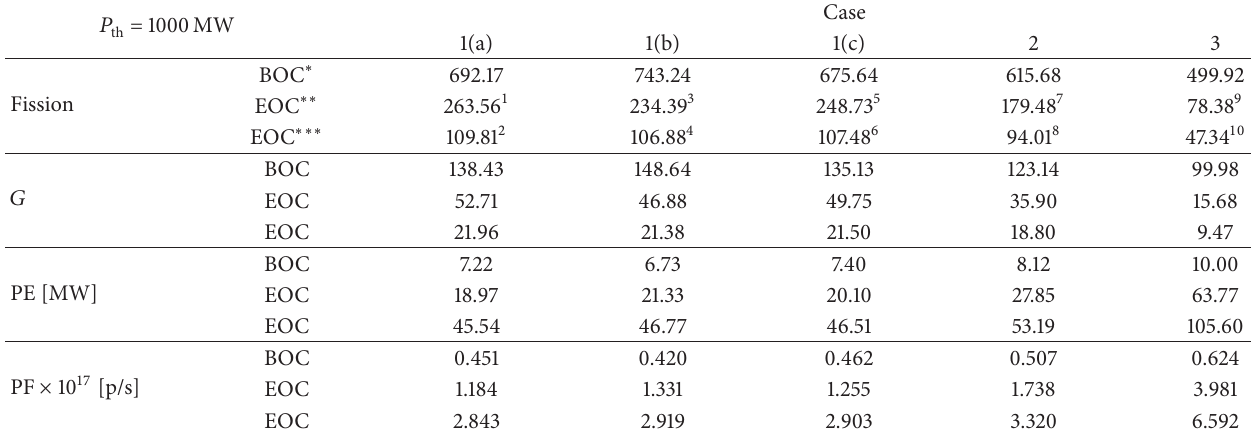
Table 5: Neutronic data at the beginning and at the end of the cycle.